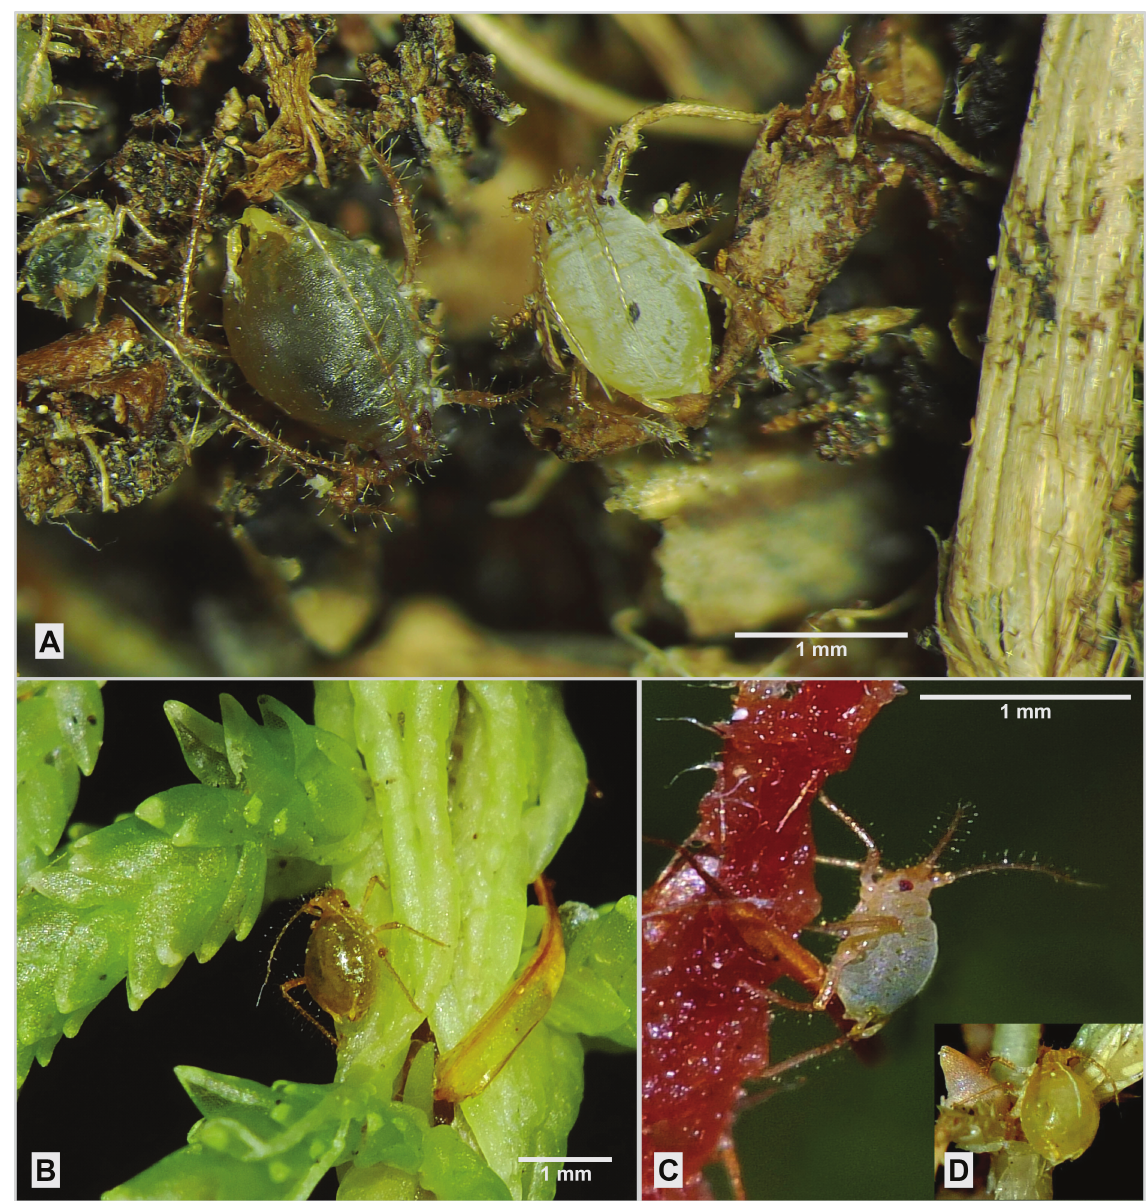
Fig. 7. Decorosiphon corynothrix börner, 1939. A . Apt. and juv. in Polytrichum commune sample. B . Apt. on Sphagnum magellanicum (with interpersed Polytrichum strictum ). C . Apt. juv. on Polytrichum commune . D . Apt. juv. on S. magellanicum , showing rupture